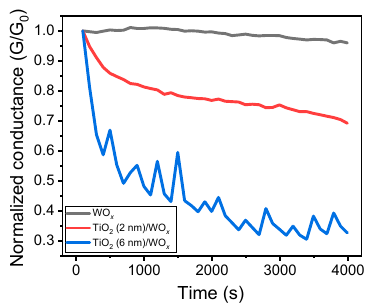
Figure 5. Drift characteristics of normalized conductance decay in the TiN/WO x /Pt device, TiN/TiO 2 (2 nm)/WO x /Pt device, and TiN/TiO 2 (6 nm)/WO x /Pt device. Figure 6a,b show three consecutive potentiation and depression curves in the TiN/WO x /Pt and TiN/TiO 2 (2 nm)/WO x /Pt devices, respectively. For potentiation, incremental increases in voltage (0.82 to 0.88125 V) are used to implement multiple conductance states for TiN/WO x /Pt. Note that a large conductance could change at any given time, representing the abrupt transition during the set process, when repeated identical pulses accumulate in a synaptic device. Moreover, highly linear conductance update is achieved, as shown in Figure 6a. On the other hand, for depression, an identical pulse can cause progressive conductance update because of the gradual switching that occurs during the reset process. For the TiN/TiO 2 (2 nm)/WO x /Pt device with non-filamentary switching, nonlinear conductance updates are obtained with repeated identical pulse inputs, as shown in Figure 6b. For potentiation and depression, increasing the number of pulses to 100 after two potentiation/depression cycles of 50 pulses each can change the dynamic range even more. On the other hand, the TiN/TiO 2 (6 nm)/WO x /Pt device is suitable for STP because of its poor retention property.